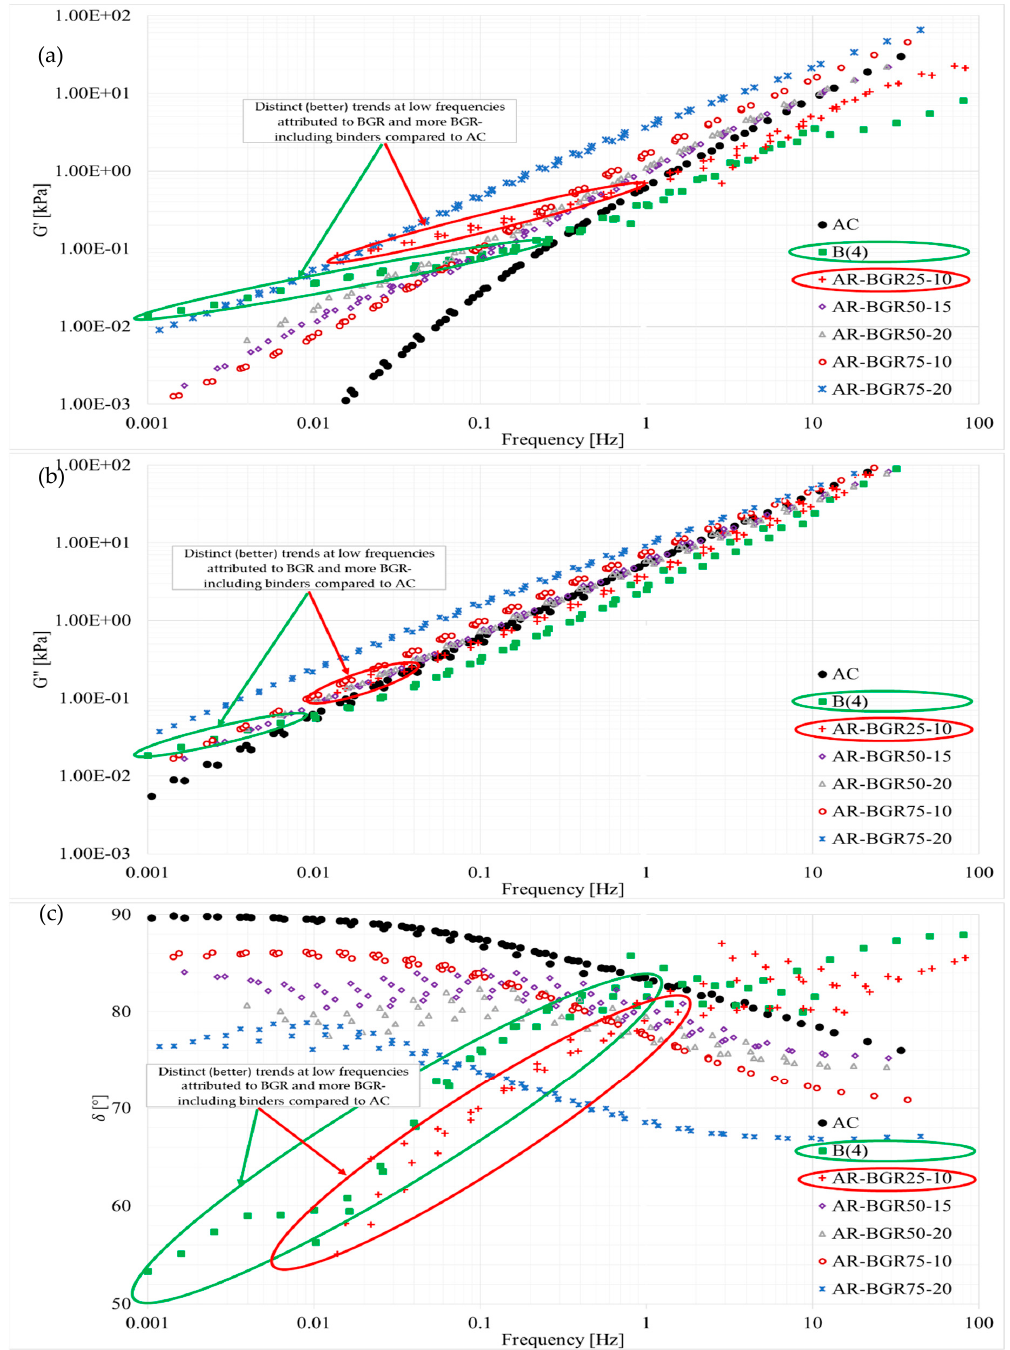
Figure 3. Master curves of asphalt–rubber–guayule whole matrices compared to asphalt cement (AC) and 4 hr heat-treated guayule resin (B(4)) at a 50 °C reference temperature: ( a ) storage modulus (G’), ( b ) loss modulus (G”), and ( c ) δ .